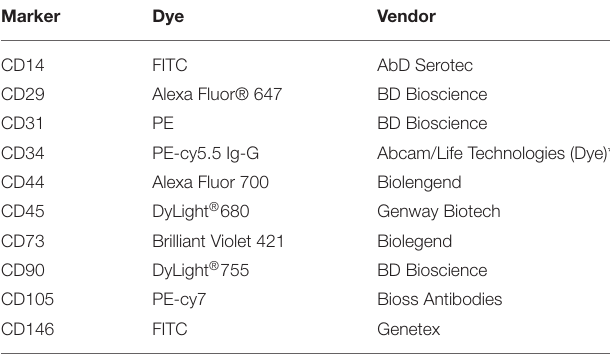
TABLE 2 | Porcine panel. Marker